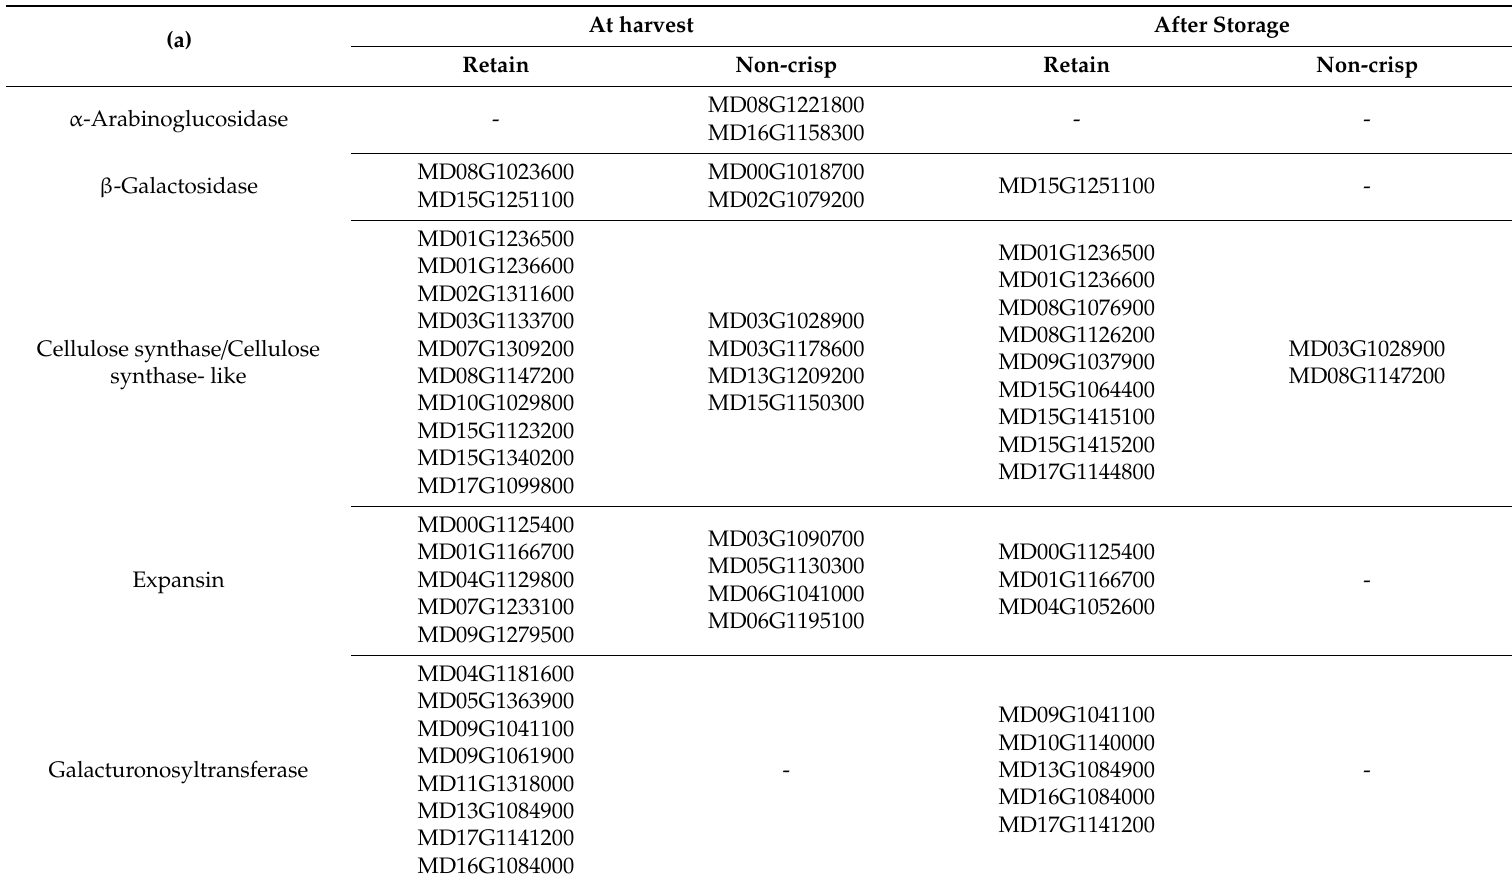
Table 1. Di ff erentially expressed genes (DEGs) with functions associated with cell wall synthesis or modification identified at harvest, or after 2-month cold storage. The expression levels of selected cell wall-genes were compared between ( a ) “Retain” vs. “Non-crisp”, ( b ) “Retain” vs. “Lose”, and ( c ) ’Honeycrisp’ vs. MN1764. The Gene IDs listed in the table were DEGs highly expressed in the corresponding phenotypic group. - = no